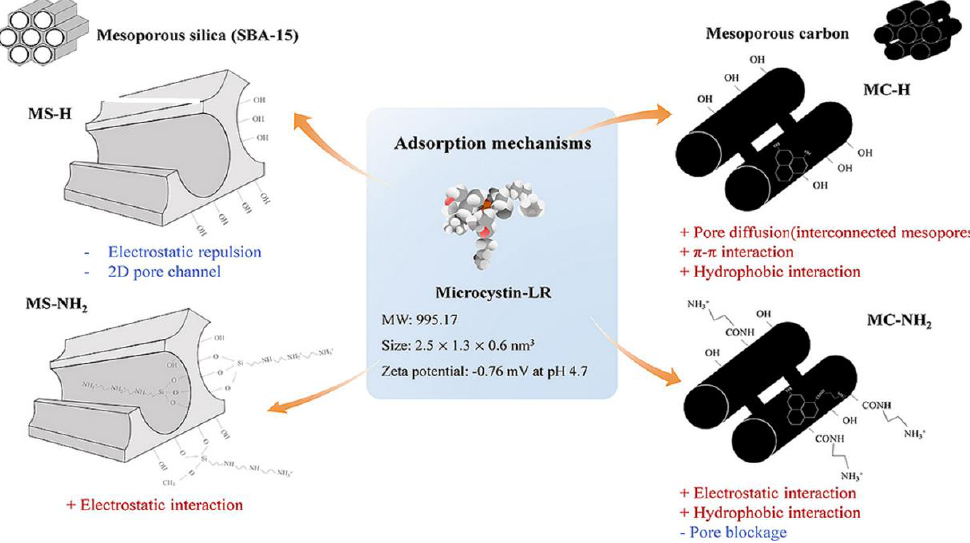
Figure 4. Governing factors for MC-LR adsorption on mesoporous silica (MS-H), mesoporous carbon (MC-H), amino-functionalized silica (MS-NH 2 ), and amino-functionalized mesoporous carbon (MC-NH 2 ). Reproduced from ref. [104] with permission from Elsevier.